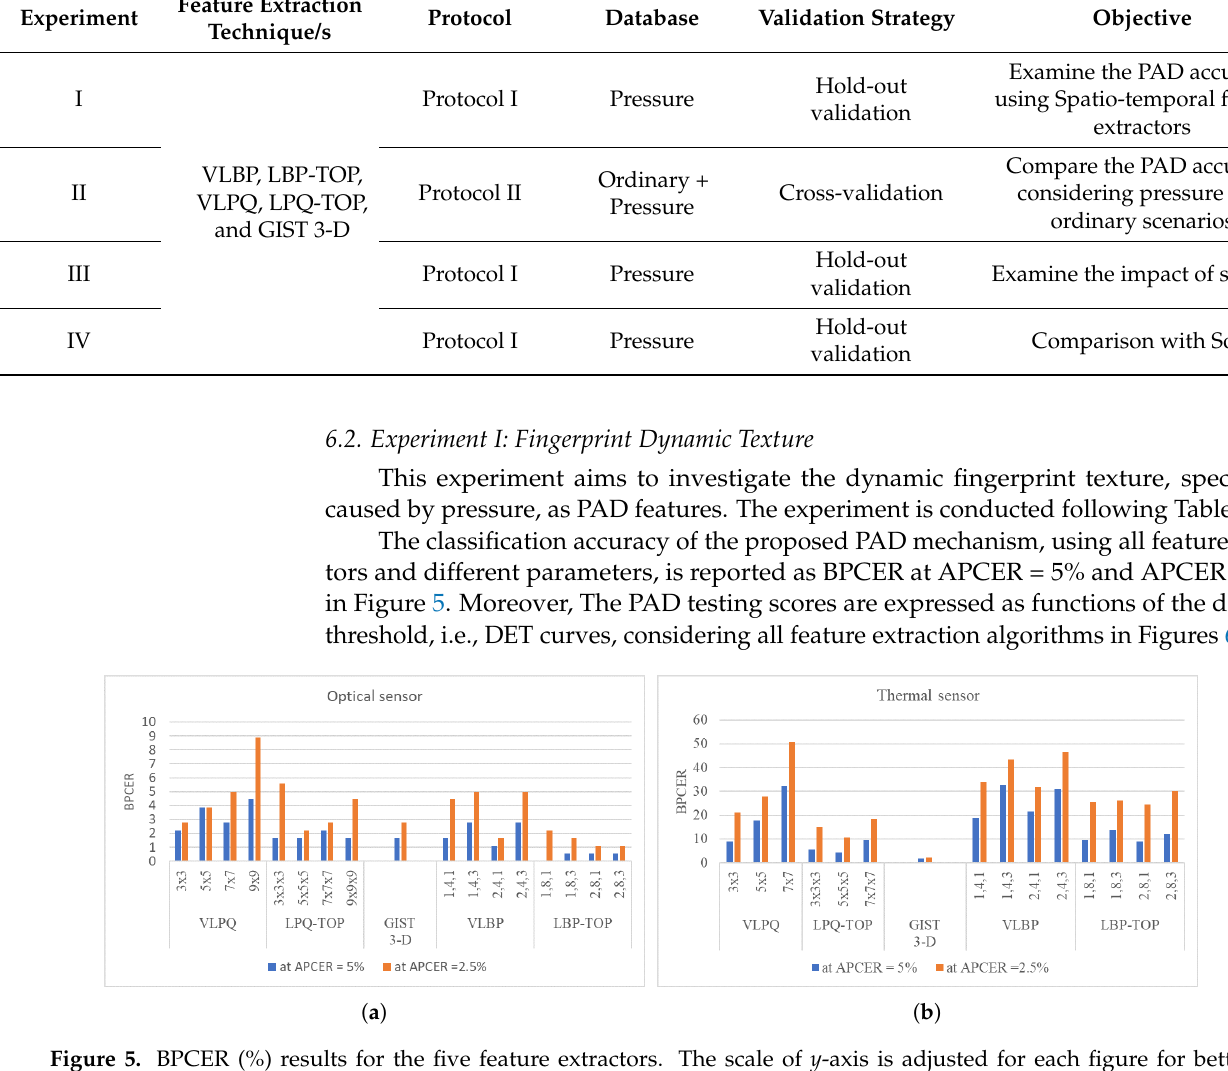
Figure 5. BPCER (%) results for the five feature extractors. The scale of y -axis is adjusted for each figure for better visualization to the obtained error